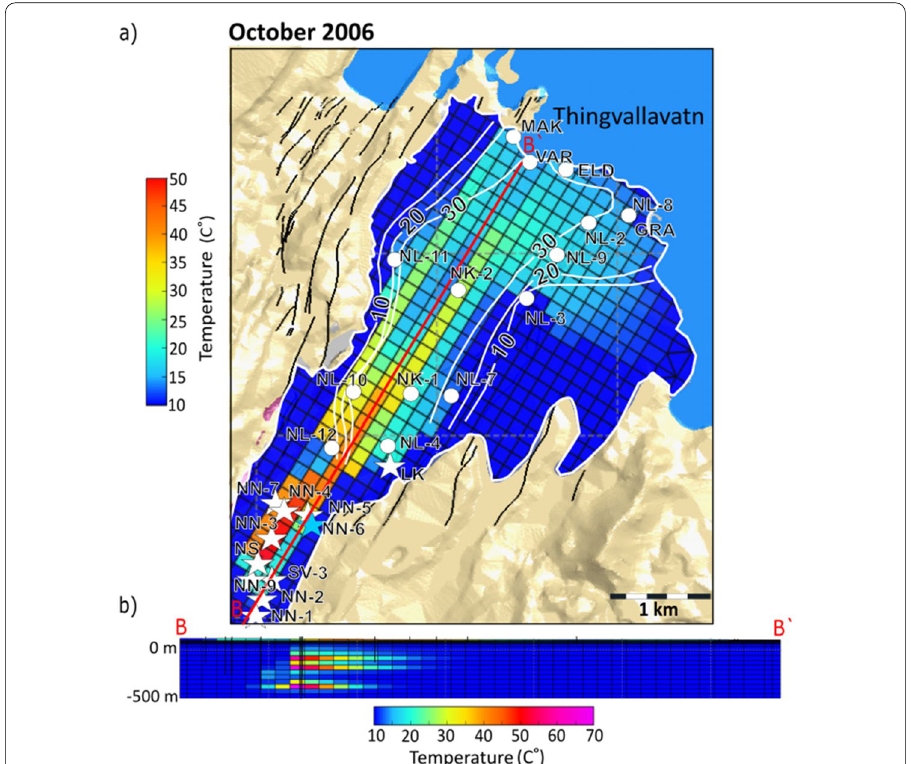
Fig. 13 a Comparison between temperature ÍSOR map and simulation for October 2006. White dots are the monitoring station, white stars are the injection wells and blue star is the injection well NN‑6 chosen for the tracer test. Groundwater temperature one meter below the groundwater table. b Cross section along the most permeable fault